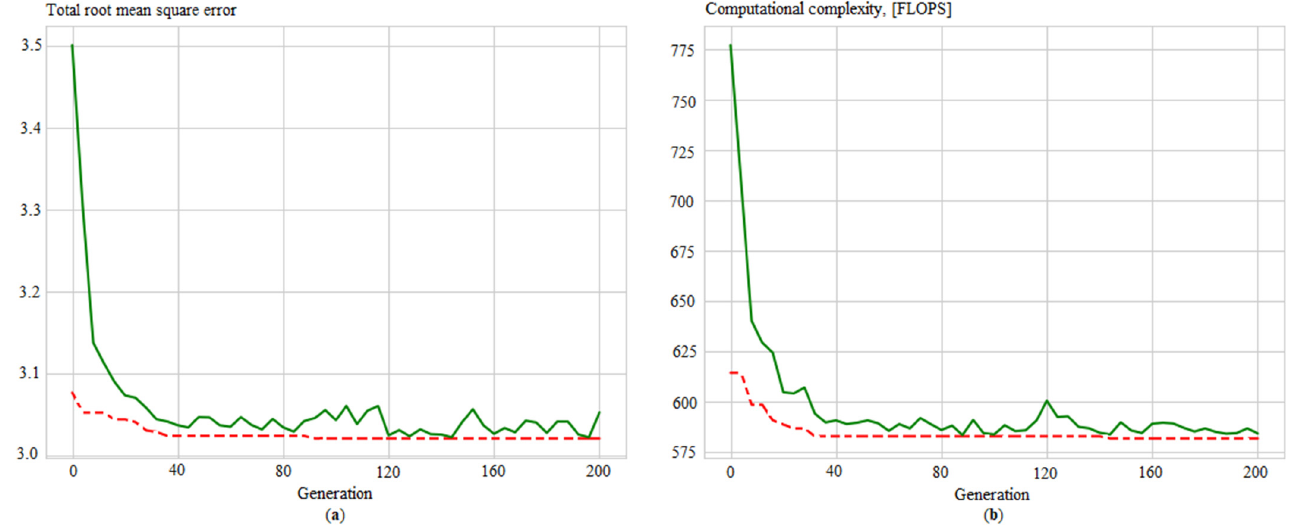
Figure 14. Evolution of the ANN predict in the process of determining its best structure by: ( a ) total root mean square error; ( b ) computational complexity, where solid green lines are average values per generation, and dotted red lines are minimum values per generation.